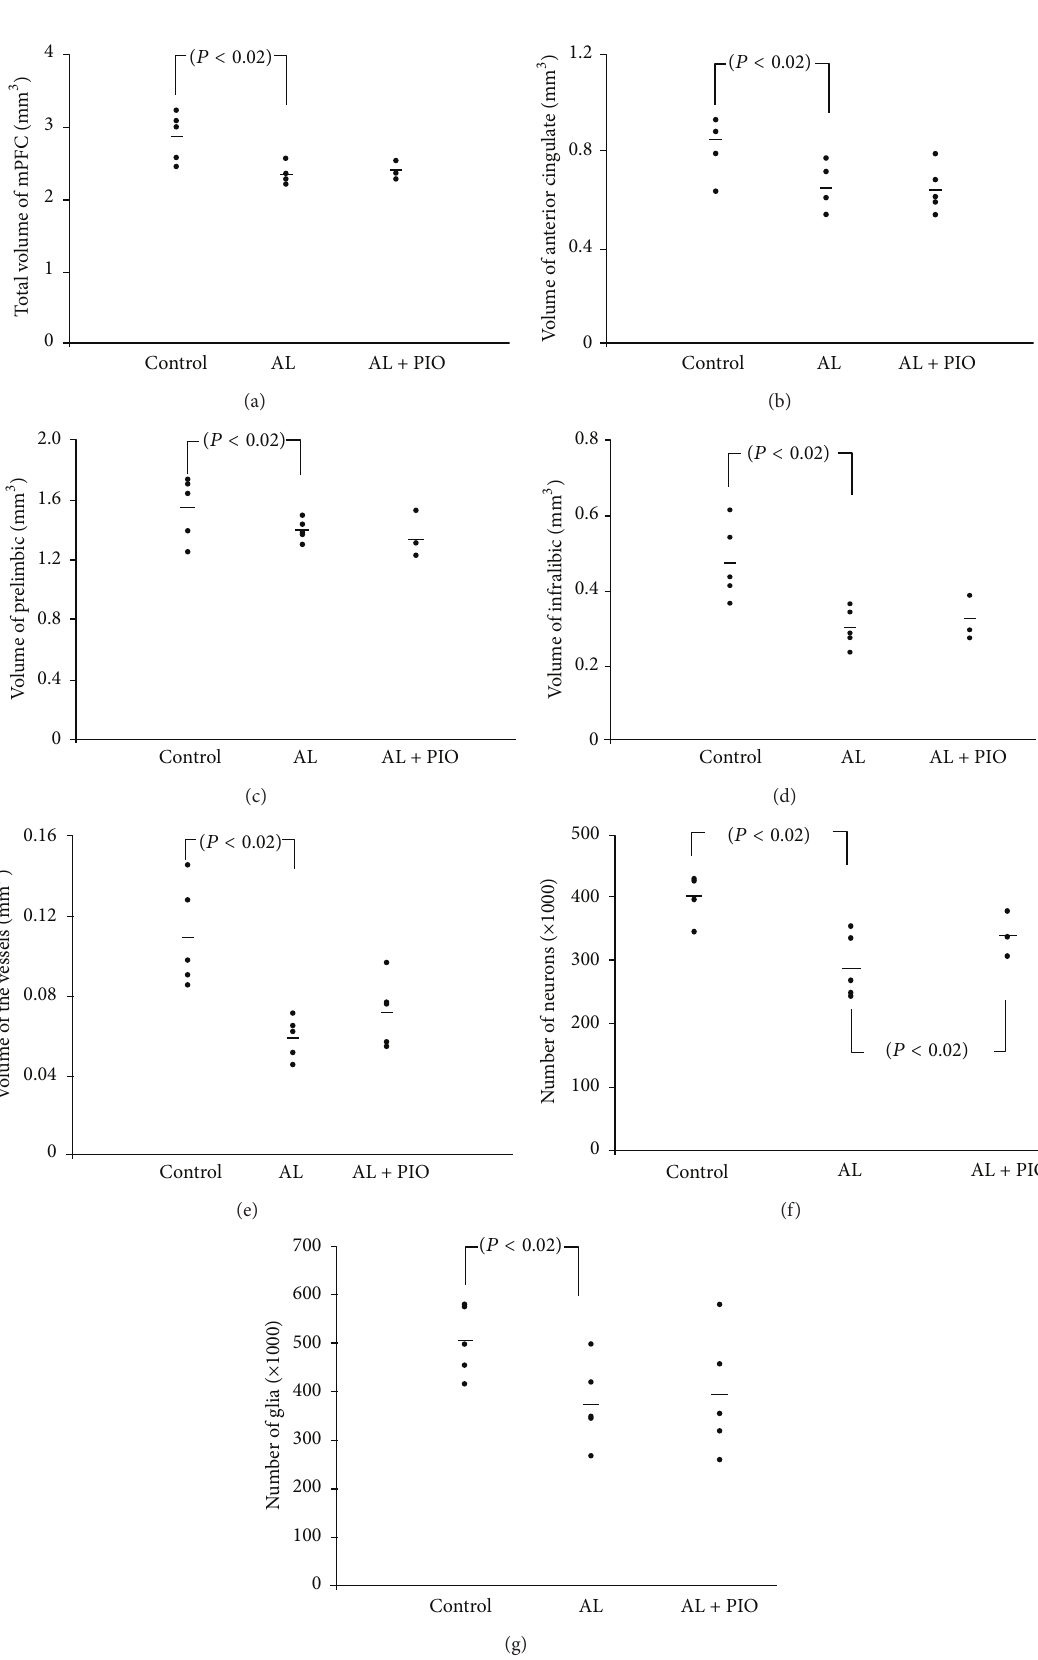
Figure 2: The scattered plots of the total volume of the mPFC (a), anterior cingulate cortex (b), prelimbic cortex (c), infralimbic cortex (d), vessels (e), number of neurons (f), and number of glial cells (g) in the control, Al, and Al + PIO